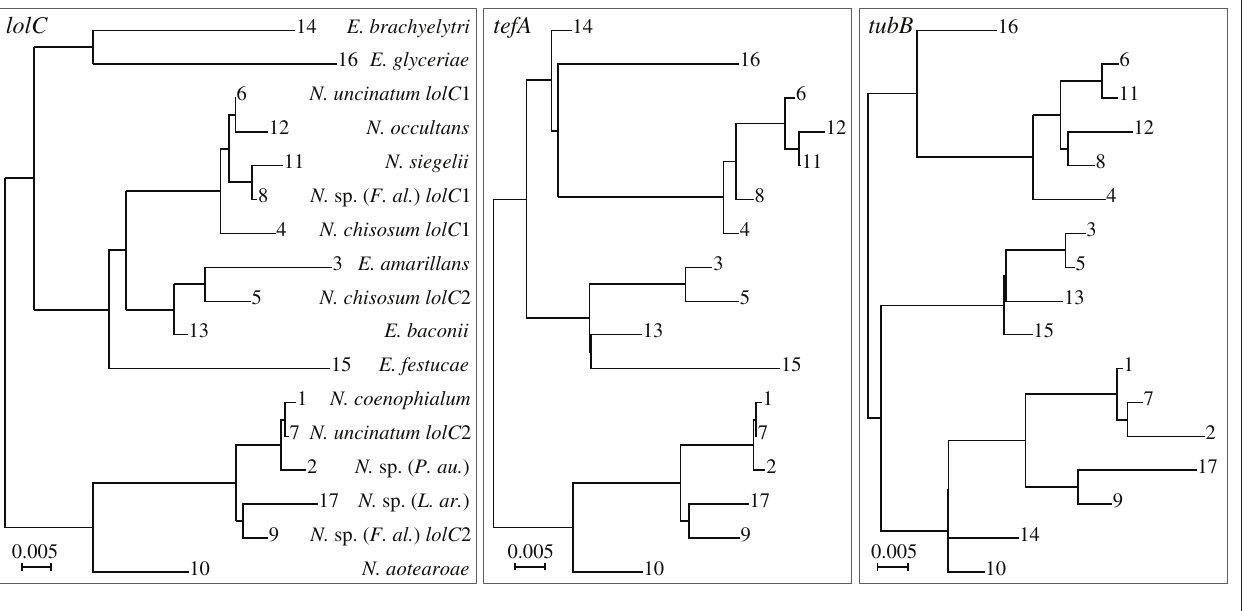
Figure 4 | Trees with maximum likelihood identified by MCMC search on aligned intron sequences from the lolC , tefA , and tubB genes of Epichloe and Neotyphodium species. Some Neotyphodium species are interspecific hybrids that have multiple genomes from